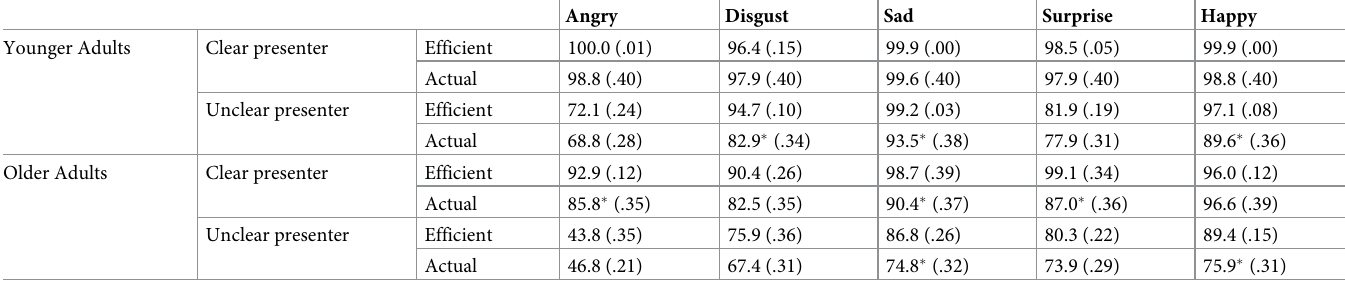
Table 2. Mean efficient and actual AV emotion percent correct recognition scores (SD) as a function of presenter and age group. Angry Disgust Sad Surprise Happy Younger Adults Clear presenter